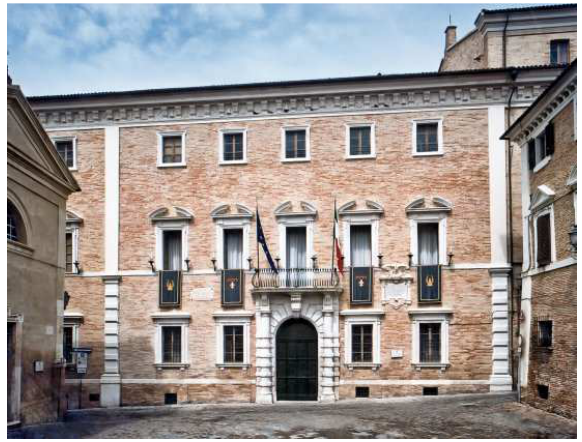
Figure 2: Campana Palace, Osimo. View of the main façade from Dante Alighieri Square.